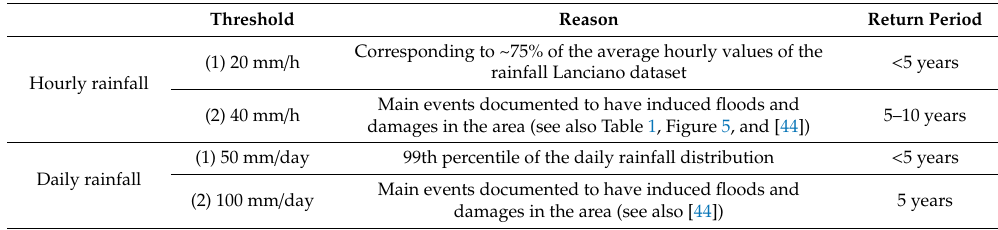
Table 8. Rainfall threshold used in the